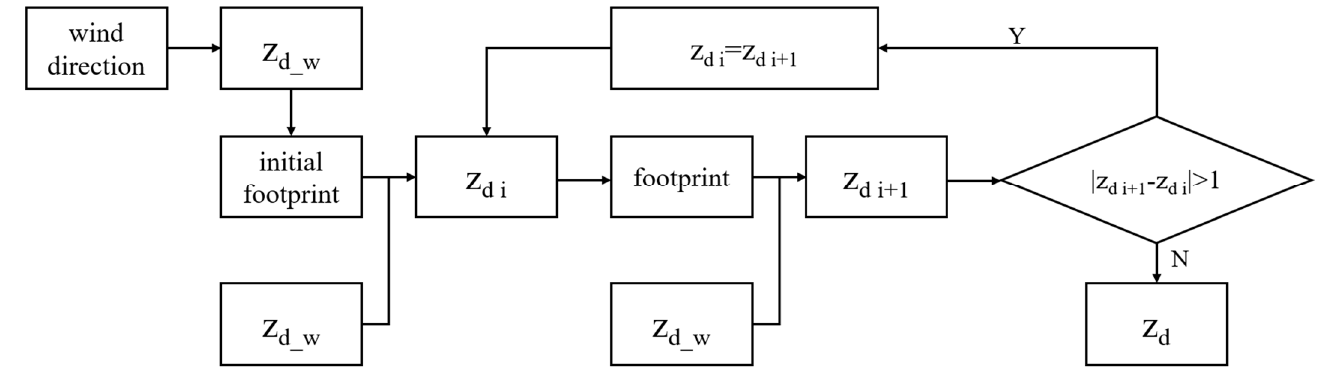
Figure 3. Flowchart showing the calculation process of z d